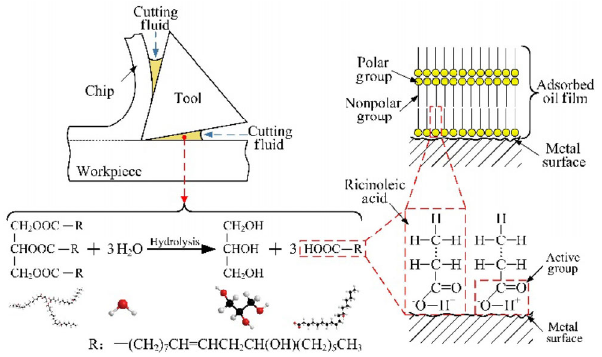
Fig. 11 Micrograph of droplet size distribution in W-O (10 wt.%) cutting fluids. Fig. 12 Lubrication mechanism of castor oil-in-water